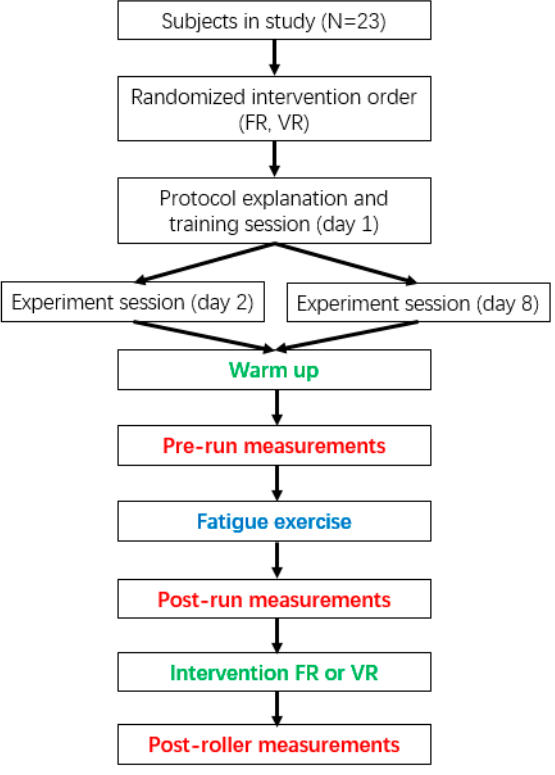
Figure 1. The flow diagram of the